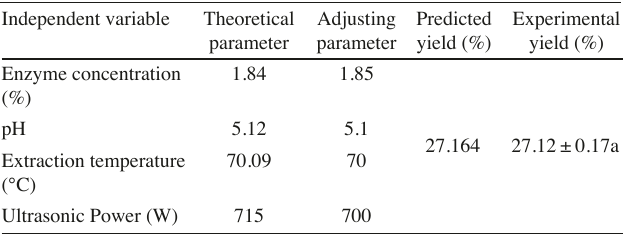
Tab. 4: Predicted and experimental yield of tea polyphenols at optimum con-